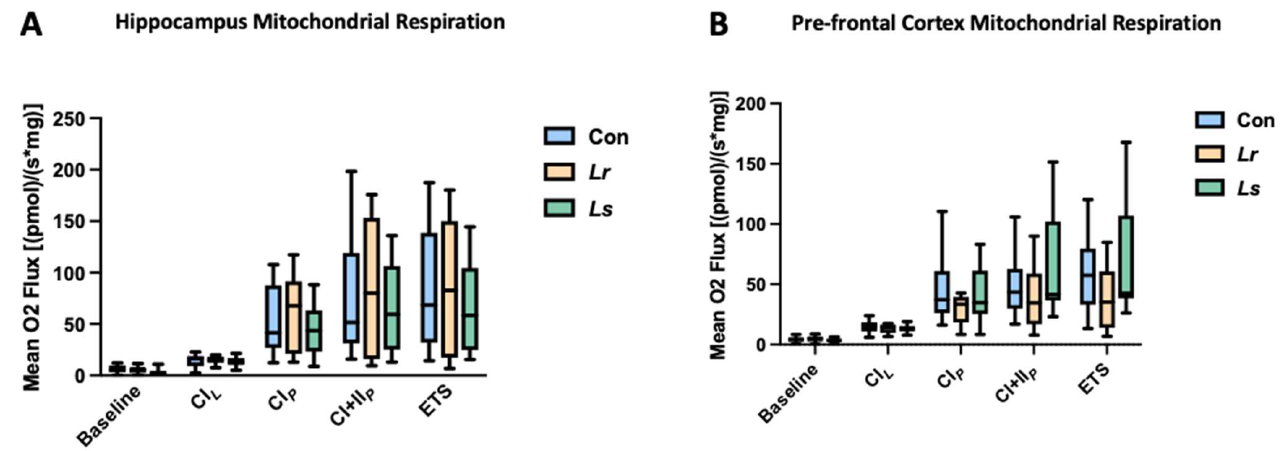
Figure 7. Effect probiotic treatment on mitochondrial respiration in the brain. Mitochondrial respiration rates were assessed in the hippocampus ( A ) and prefrontal cortex ( B ) of BTBR mice undergoing Lr, Ls, and control treatments. N = 10–16 mice/group. Abbreviations: Con—Control; Lr — L. rhamnosus HA-114; Ls — L. salivarius HA-118; CI L —Proton Leak Respiration in Complex I; CI P —Phosphorylation Respiration in Complex I; CI+II P —Phosphorylation Respiration in Complex I+II; ETS—Maximal Res-